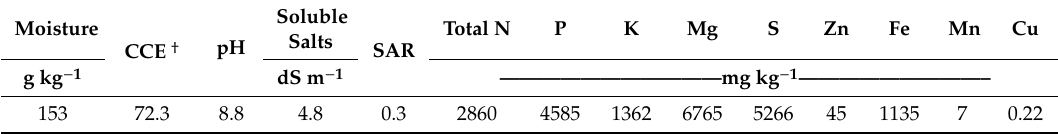
Table 1. Chemical characteristics of precipitated calcium carbonate (PCC) used in the root aphid study. Moisture CCE† pH Soluble Salts SAR Total N P